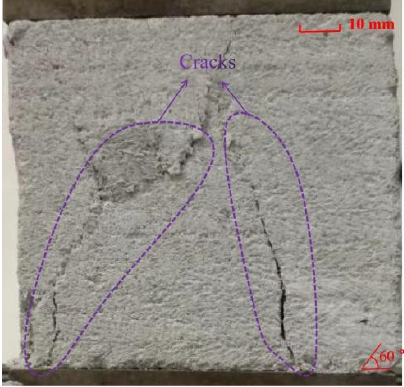
Figure 3. Sample after compressive test (dimension 100 mm × 100 mm).